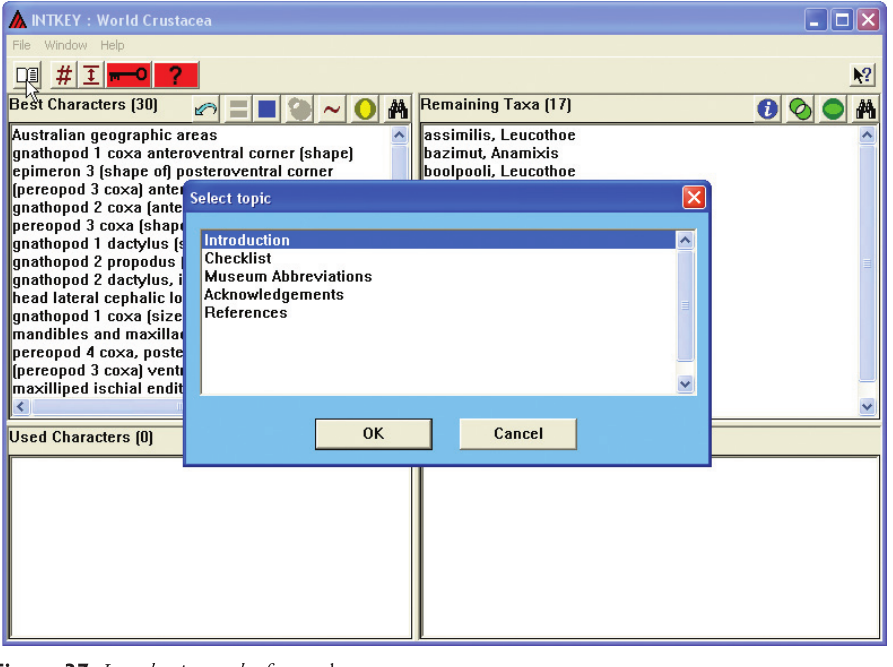
Figure 37. Introduction and references button.